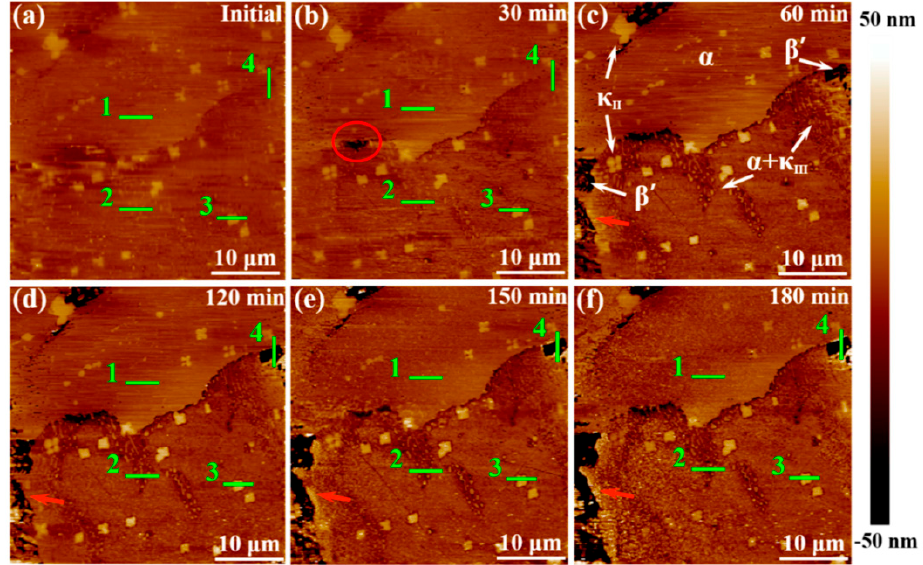
Figure 6. In situ topography images of nickel–aluminum bronze (NAB) specimen surface after exposure to 3.5 wt% NaCl solution at different times: ( a ) initial; ( b ) 30 min; ( c ) 60 min; ( d ) 120 min; ( e ) 150 min; ( f ) 180 min. Site 1 corresponds to the α phase, site 2 corresponds to the α + κ III eutectoid structure, and site 3 corresponds to the κ II phase, while site 4 corresponds to the β ’ phase. Reprinted with permission from Reference [44]; copyright 2019 MDPI.